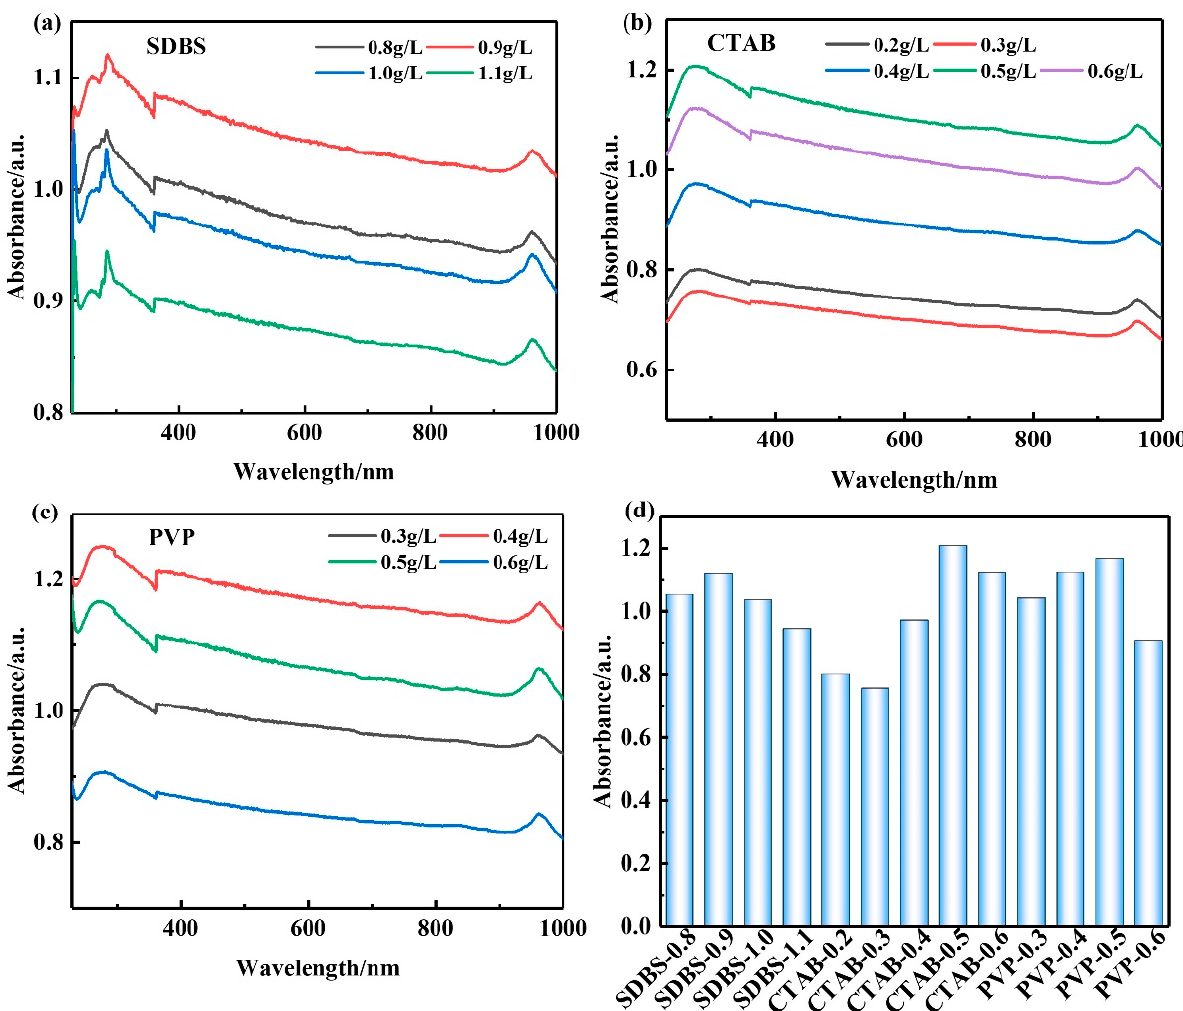
Figure 1. UV–VIS spectra of GNPs with different surfactant concentrations; ( a ) SDBS, ( b ) CTAB, ( c ) PVP, ( d ) maximum absorbance.